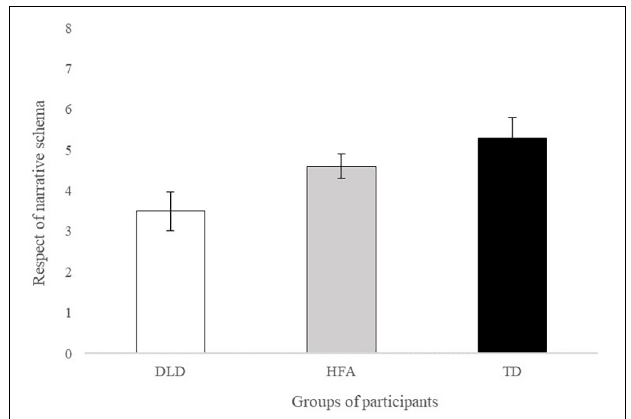
FIGURE 1 | Respect of narrative schema in the narratives of DLD, HFA and TD participants. Error bars represent standard errors.